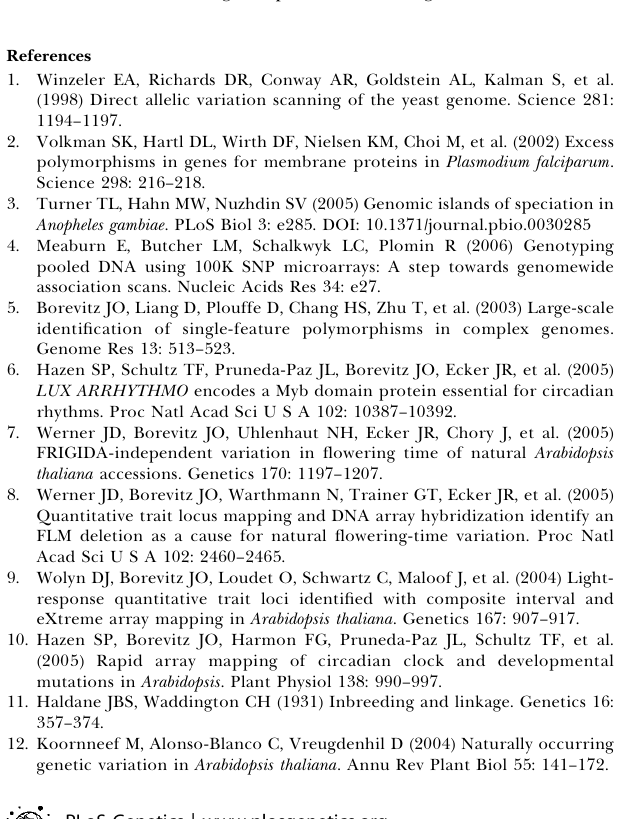
Figure S12. Segregation Distortion of SFP Markers for Chromosomes 2–5 Segregation ratios of genotypes for each informative SFP marker were calculated across 98 RILs and plotted along the chromosome. The vertical scale shows allele ratios. The expected equal distribution of Col and L er alles accross 98 lines should result in a ratio of 1 and is depicted as a dotted horizontal line. SFP markers with allele ratios above the line indicate segregation distortion towards the Col allele, SFP markers with allele ratios below the line indicate segregation distortion towards the L er allele. Empty diamonds represent SFP markers with no significant segregation distortion from the expected ratio of 1 between Col and L er genotypes. Filled triangles represent markers that show a significant ( p (cid:1) 0.05, Fisher’s exact test) segregation distortion towards the Col genotype. Found at DOI: 10.1371/journal.pgen.0020144.sg012 (2.8 MB PDF). Table S1. SFPs Identified between Col and L er Parental Lines at a 5% FDR after 210 Permutations Found at DOI: 10.1371/journal.pgen.0020144.st001 (1.4 MB TXT). Table S2. SFPs Identified between Col and L er Parental Lines at a 1% FDR after 210 Permutations Found at DOI: 10.1371/journal.pgen.0020144.st002 (1.1 MB TXT). Table S3. Putatively Deleted Genes in L er Compared to Col Found at DOI: 10.1371/journal.pgen.0020144.st003 (228 KB DOC). Table S4. Genome-Wide SFP Distribution Based on 50-kb Window Size Found at DOI: 10.1371/journal.pgen.0020144.st004 (30 KB DOC). Table S5. Informative SFP Markers Used for Genetic Mapping in 98 Lines of the Col/L er RIL Population [13] Found at DOI: 10.1371/journal.pgen.0020144.st005 (1.3 MB DOC). Table S6. List of Informative SFP Markers with Associated Genotypes for 98 Lines of the Col/L er RIL Population [13] Found at DOI: 10.1371/journal.pgen.0020144.st006 (199 KB TXT). Table S7. Genetic Linkage Map with Centimorgan Distances for the